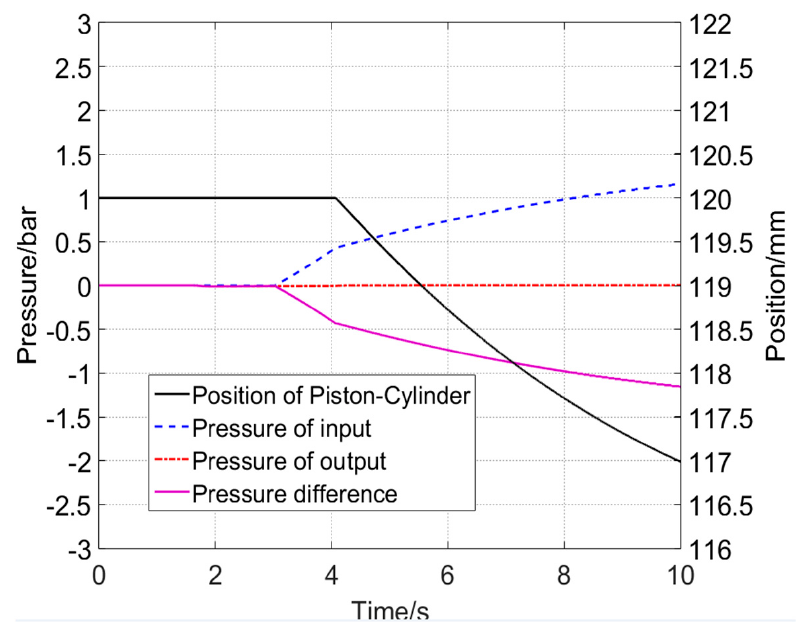
Figure 24. The simulation results of the position and the pressure when the pump speed is 20 RPM when the load is applied.